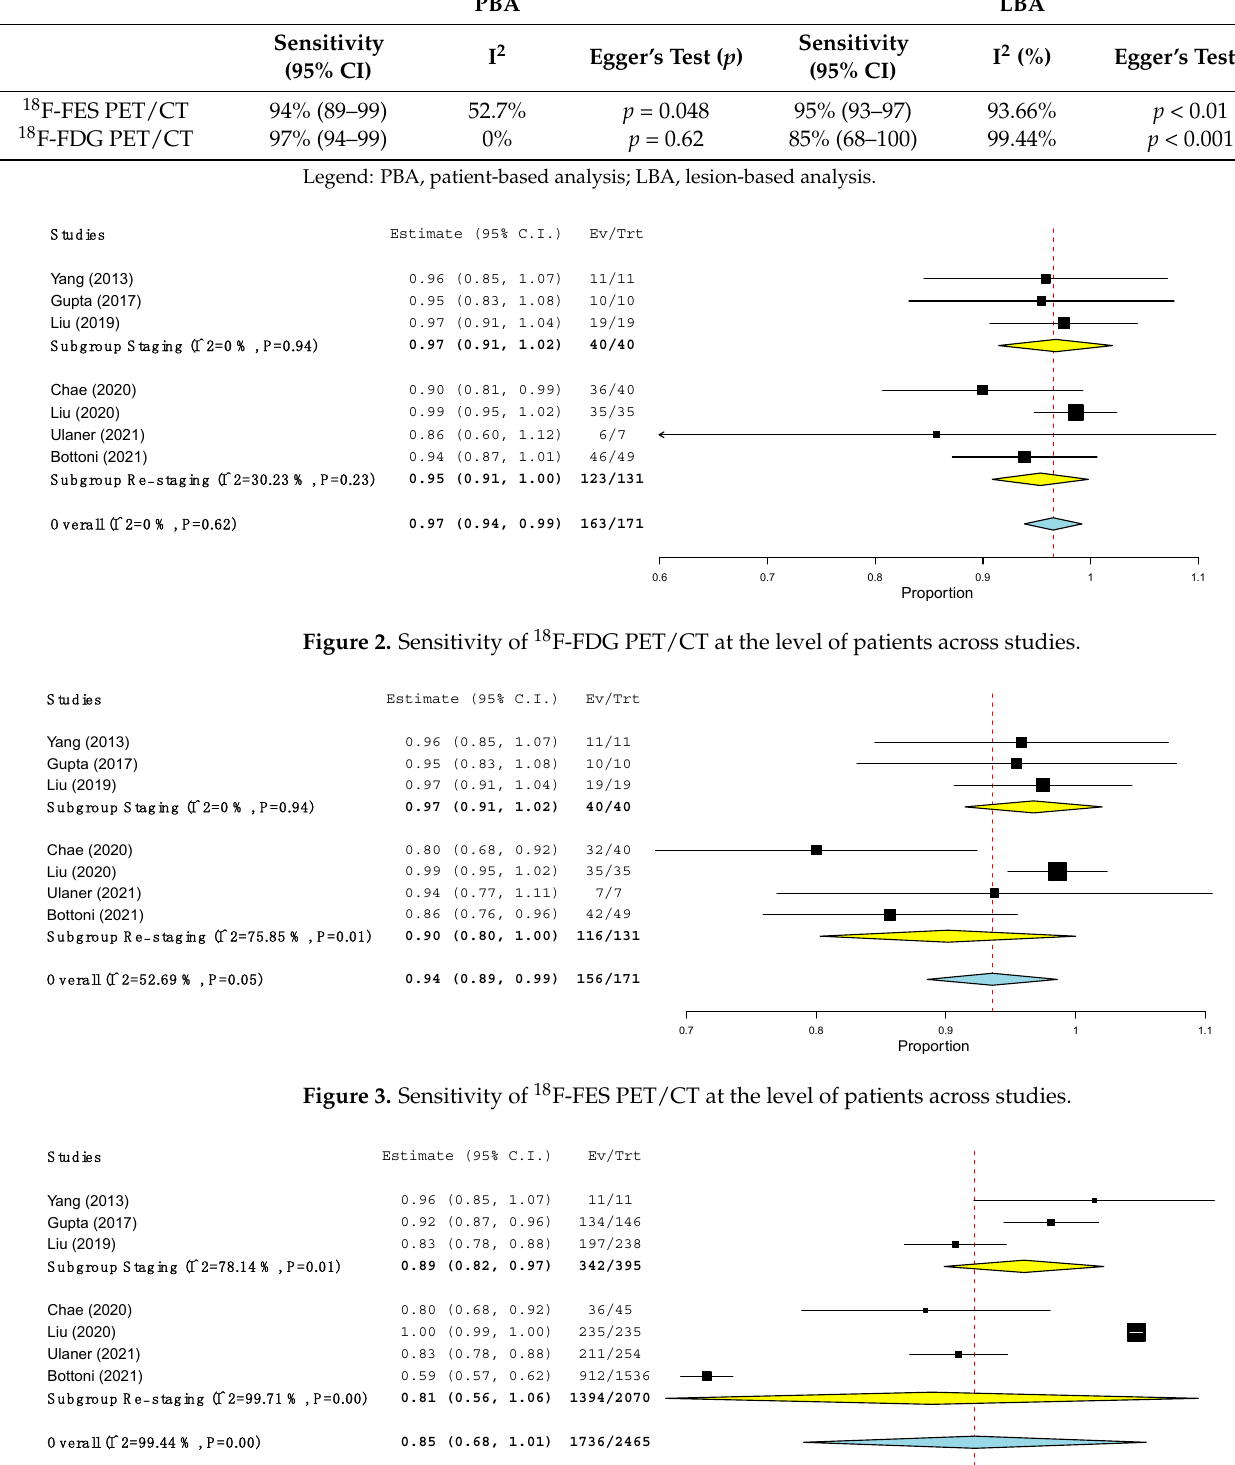
2 and 3). Table 5. Pooled sensitivity for PBA and LBA of 18 F-FES PET/CT and 18 F-FDG PET/CT. PBA LBA